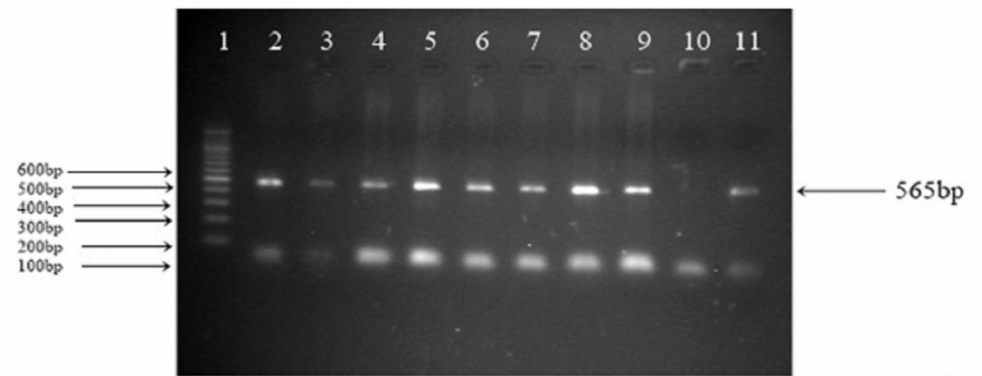
Figure 3. Detection of the Cry1Ac gene fragment in transformed cotton plants by PCR amplification. Lanes 2–9 showed the amplicons obtained for the Cry1Ac gene (565 bp) in putatively transformed cotton plants. Lane 1 contains the 1 Kb p DNA marker. Lanes 2–5 contains amplicons from the CLCuV-Ac transformed cotton plants. Lanes 6–9 contains amplicons from PK2-Ac transformed cotton plants. Lane 10 is the negative control, and Lane 11 contains the amplicons from the plasmid CLCuV-Ac used as the positive